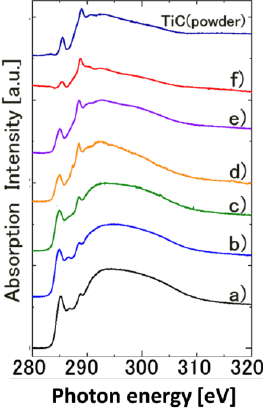
(e) [1.2 × 10 19 atoms·cm −2 ] and (f) [1.2 × 10 20 atoms·cm −2 ].